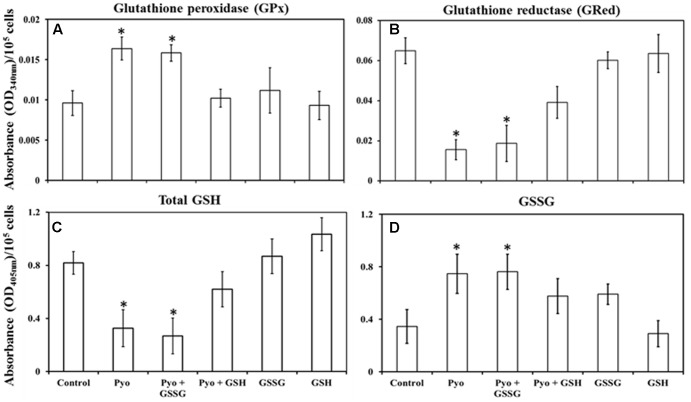
Quantification of glutathione peroxidase, glutathione reductase, total glutathione, and glutathione disulphide in pre-established A549 cells. (A) A549 cells treated for 24 h with pyocyanin or pyocyanin + GSSG showed a significantly higher glutathione peroxidase (GPx) activity compared to control, pyocyanin + GSH, GSSG and GSH. (B) Glutathione reductase (GRed) activity of pyocyanin and pyocyanin + GSSG treated A549 cells was significantly lower compared to control, pyocyanin + GSH, GSSG and GSH-treated cells. (C) Total intracellular GSH levels of A549 cells exposed to pyocyanin and pyocyanin + GSSG were significantly lower compared to A549 cell exposure to control, pyocyanin + GSH or GSSG or GSH. (D). Intracellular GSSG level was elevated in pyocyanin and pyocyanin + GSSG treated A549 cells in comparison to control, pyocyanin + GSH, GSSG or GSH-alone treatment. (A–C)
∗P < 0.05 compared to treatment with control, pyocyanin + GSH, GSSG and GSH. (D)
∗P < 0.05 compared to treatment with control and GSH. Data represent mean ± SD; n = 4 biological replicates.